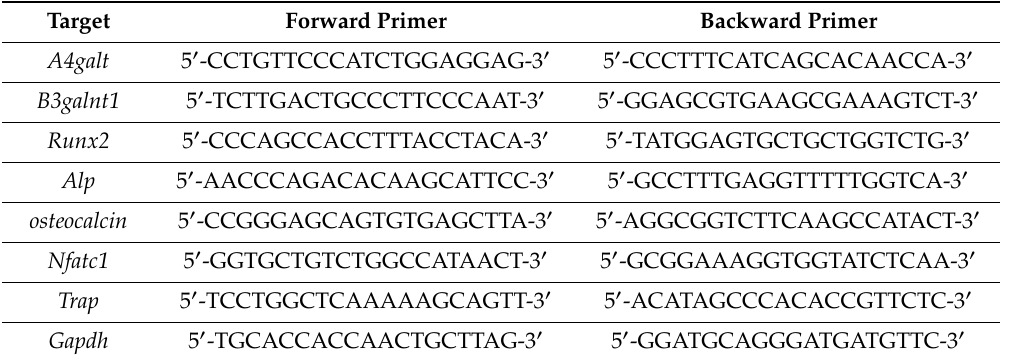
Table 1. Real-time PCR primers used in this